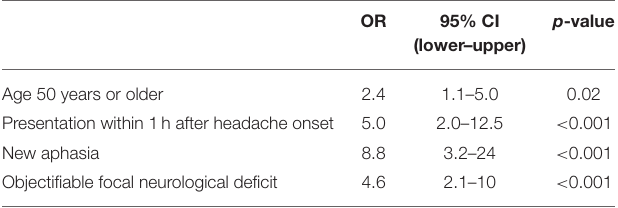
TABLE 3 | Multivariate analysis of predictors for intracranial pathology on CT